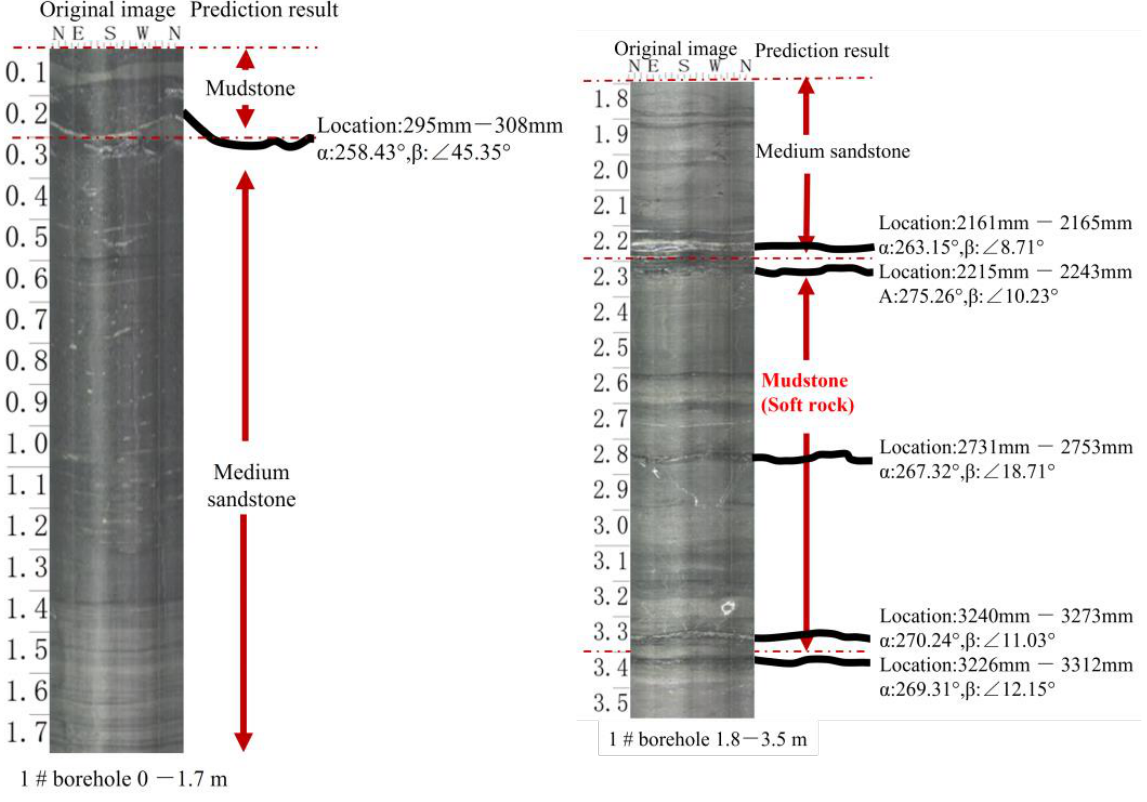
Figure 15. Analysis of LWD Results of Borehole 1 #.